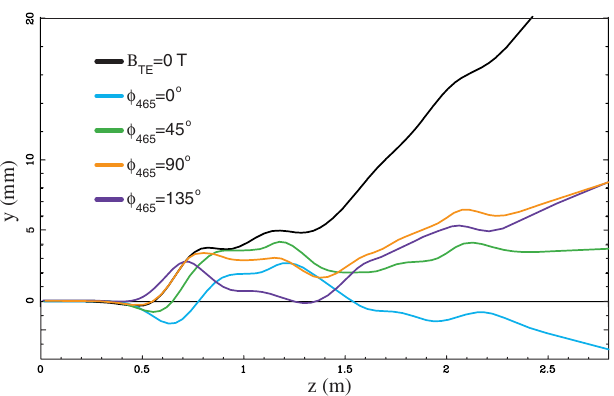
FIG. 7. (Color) Bunch trajectories in LEP cavity excited by three rf fields: TM 010 352 MHz ( E max ¼ 5 MV = m ), dipole TE 111 465 MHz ( B max ¼ 0 : 01 T ), and TE 021 1013 MHz ( B TE ¼ 0 : 1 T ).